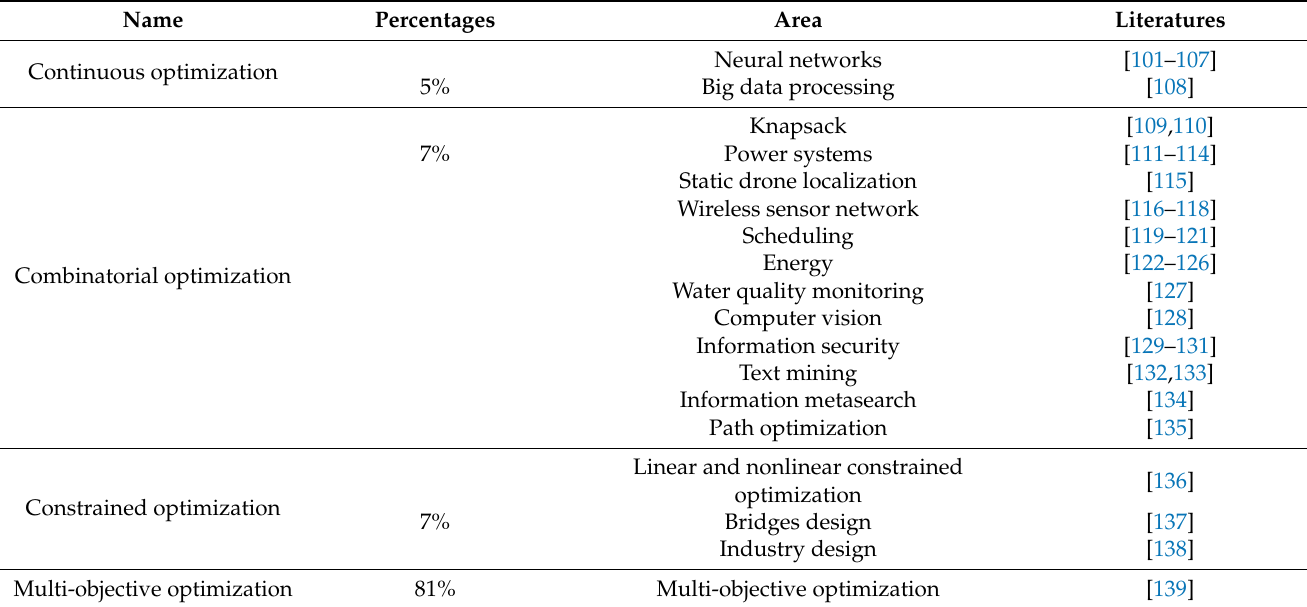
Table 3. The classification of engineering